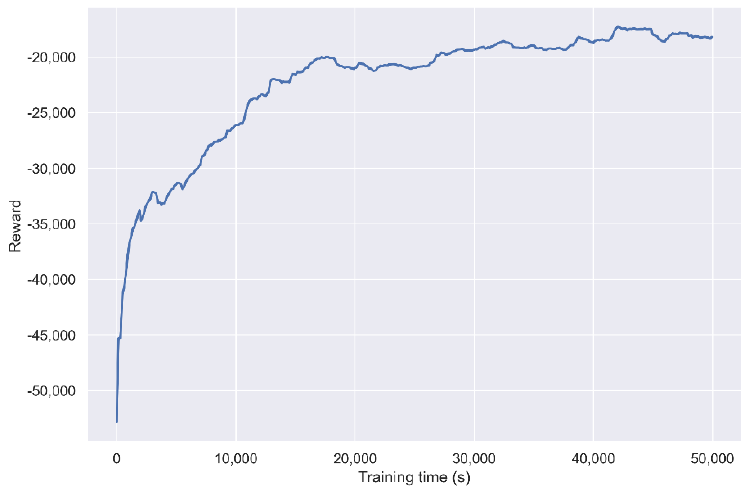
Figure 3. The training process of the traffic lights with RAINBOW.